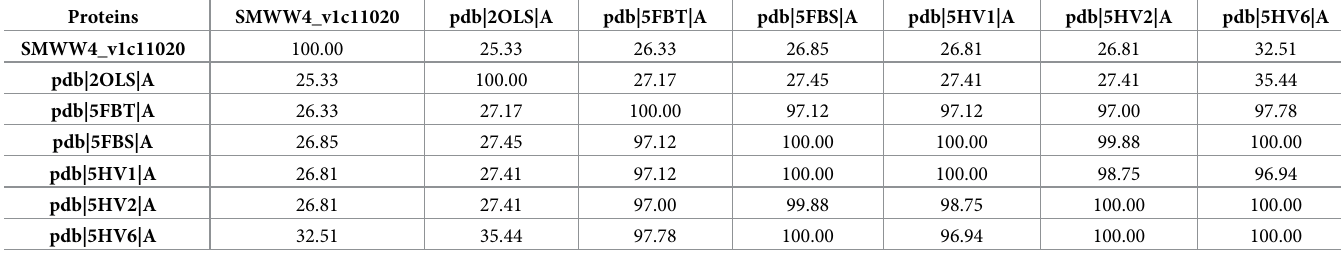
Table 4. Percent similarity